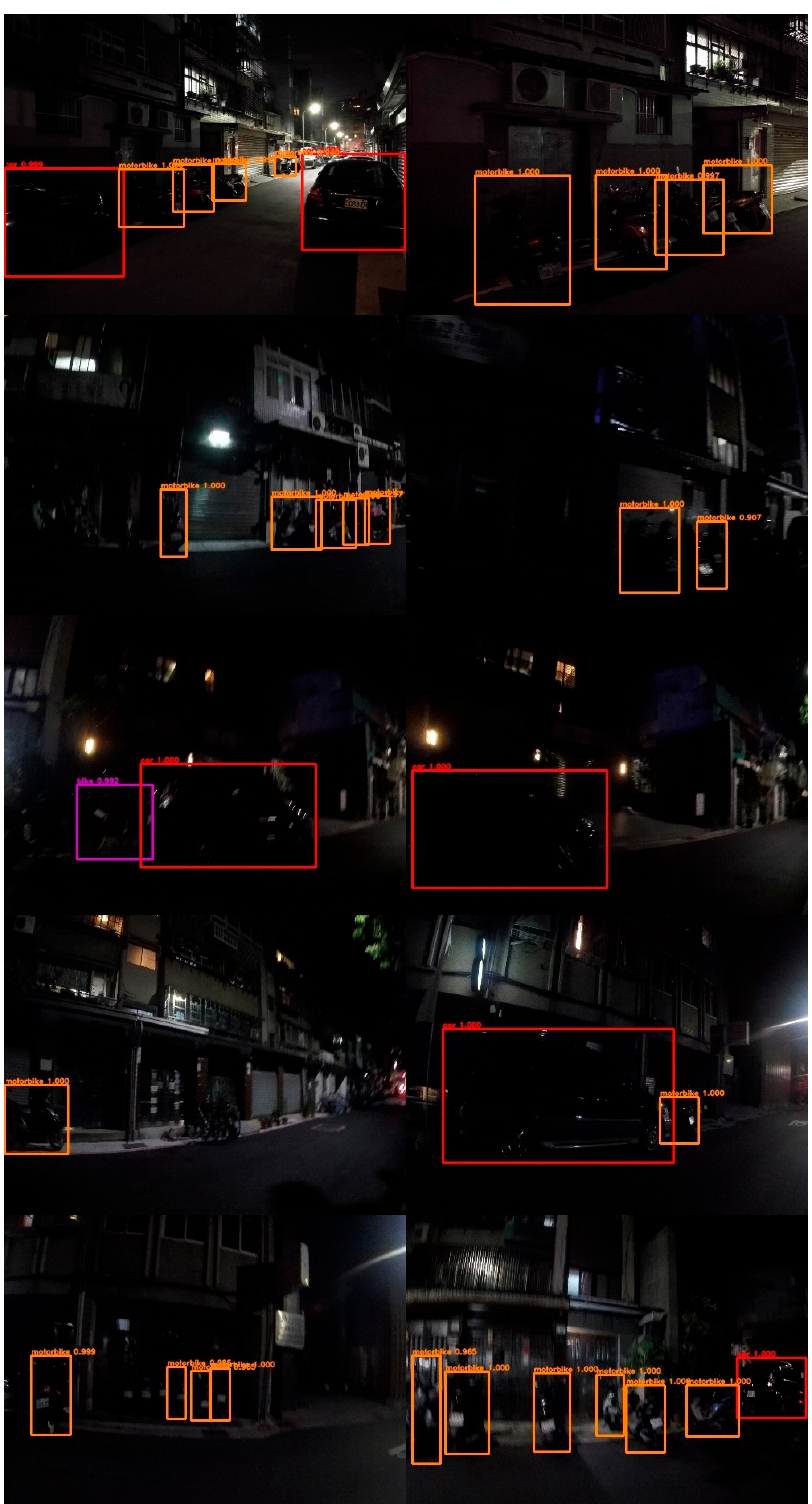
Figure 25. Outputs from the Faster R-CNN [5] with ResNet101 [2] in our proposed system trained using our nighttime data.